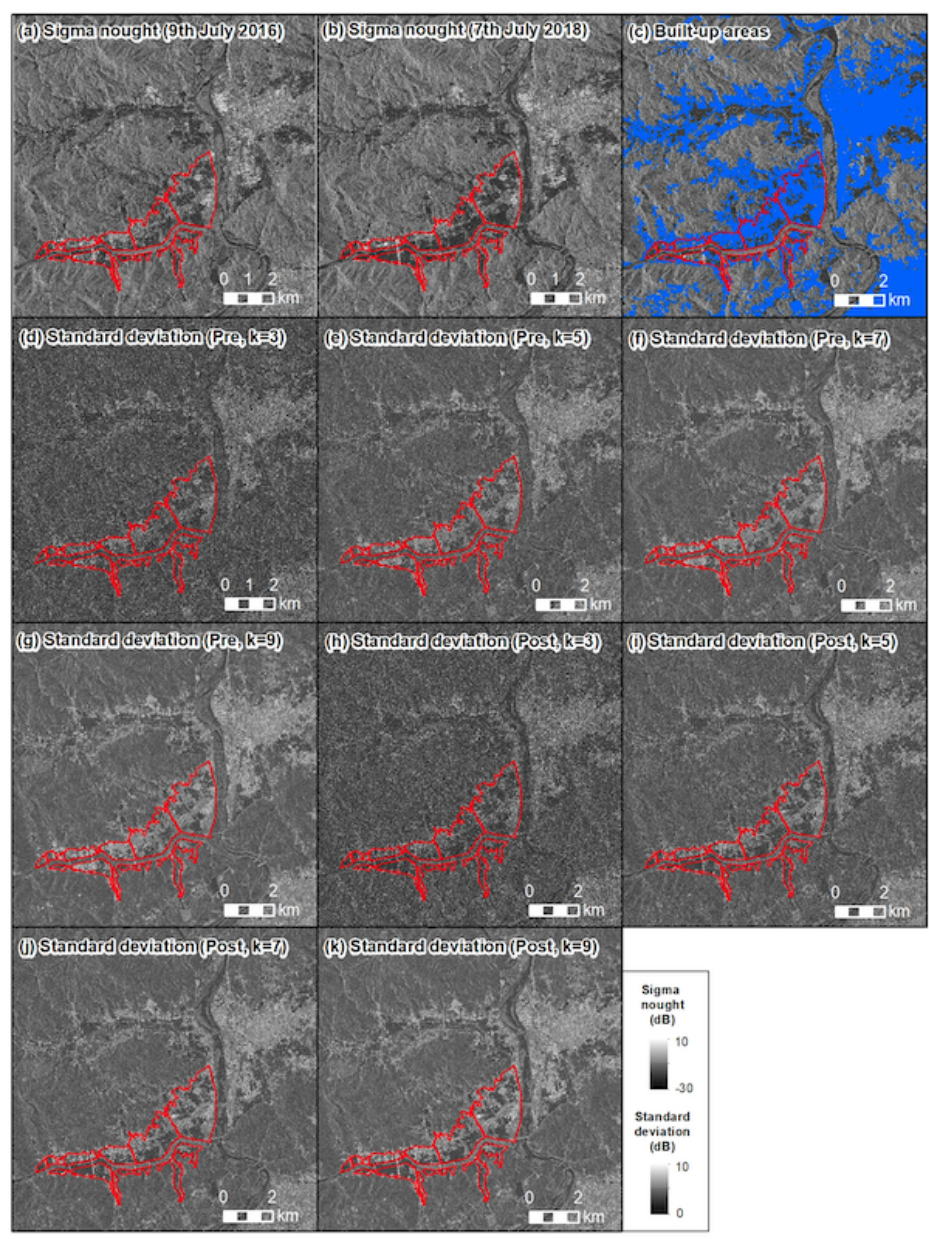
Figure 8. Examples of standard deviation images: ( a ) sigma nought image on 9 July 2016; ( b ) sigma nought image on 7 July 2018; ( c ) distribution of built-up areas, illustrated by blue color; ( d – g ) are pre-event standard deviation images with ( d ) a kernel size of 3, ( e ) kernel size of 5, ( f ) kernel size of 7, and ( g ) kernel size of 9; ( h – k ) show the post-event standard deviation images with ( h ) a kernel size of 3, ( i ) kernel size of 5, ( j ) kernel size of 7, and ( k ) kernel size of